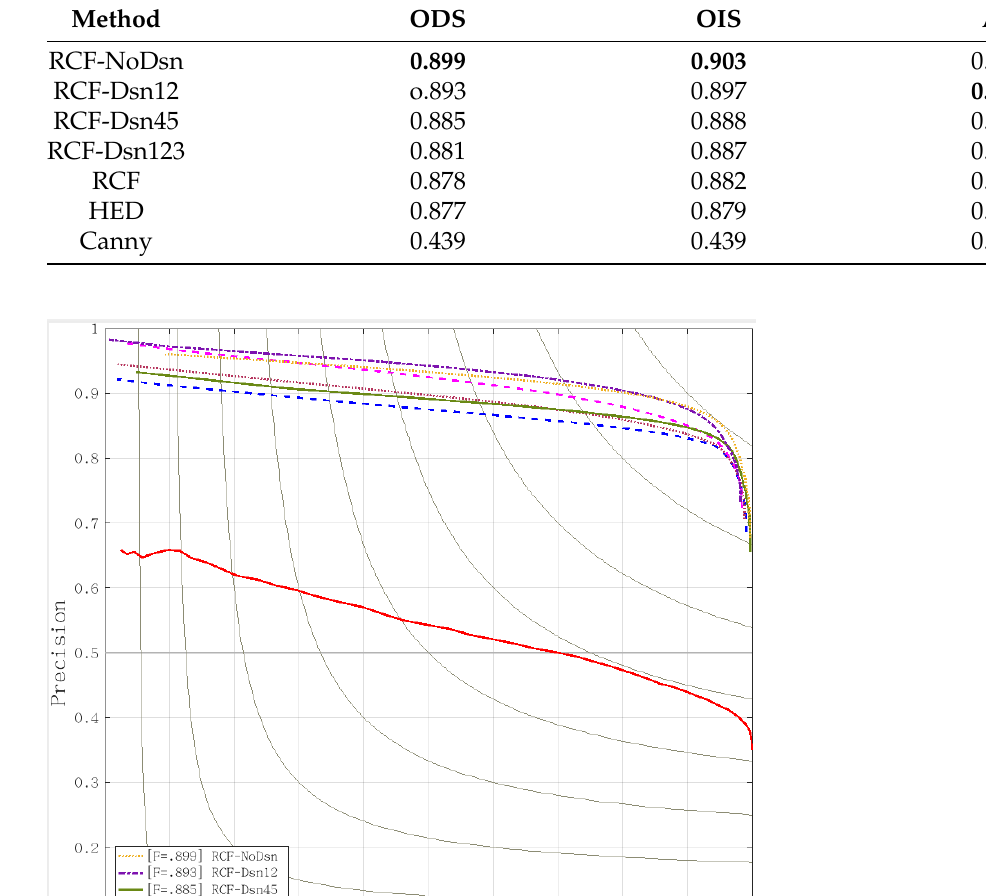
Table 3. Comparison of experimental results of edge detection algorithms.